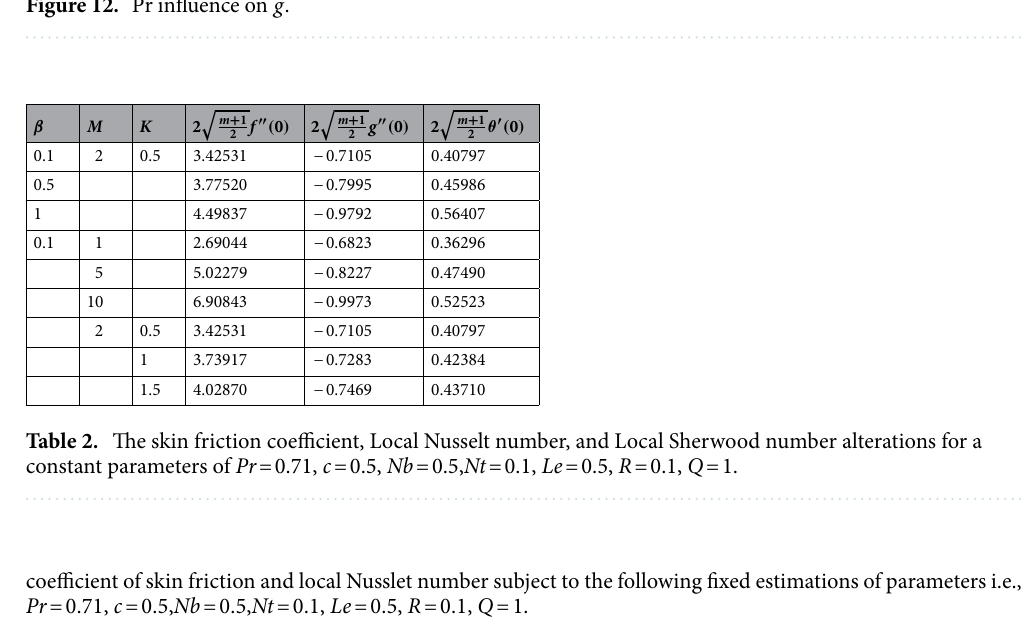
Figure 12. Pr influence on g .